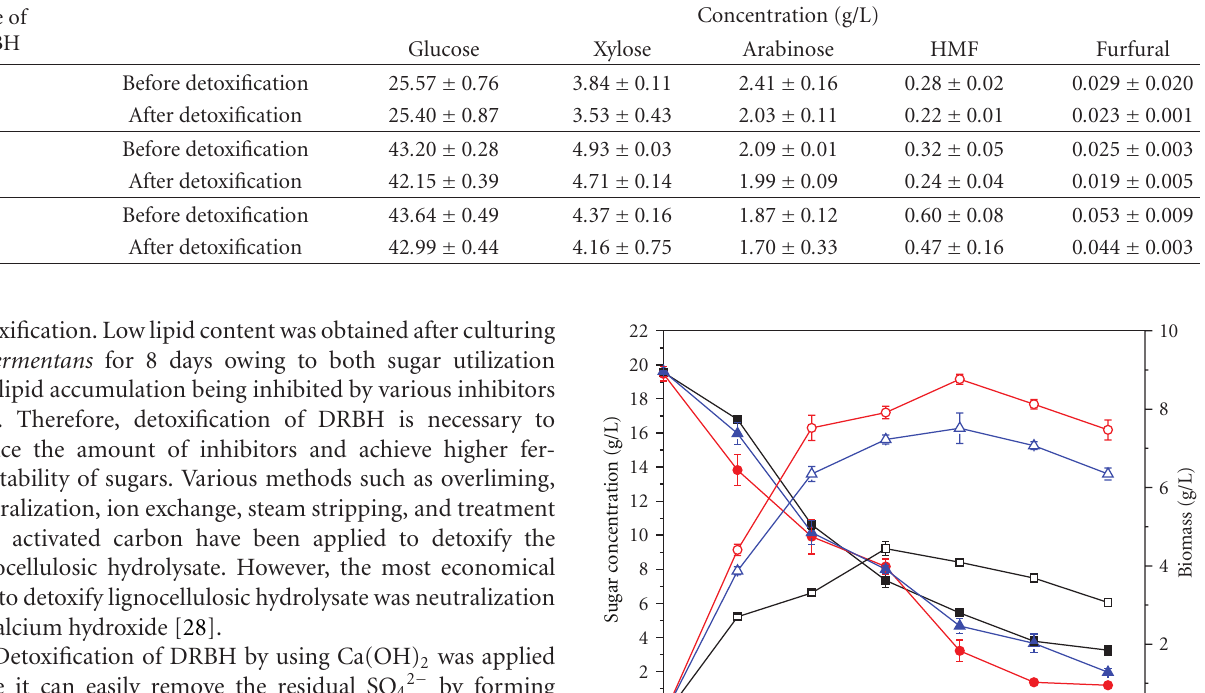
Three di ff erent types of detoxified DRBHs were obtained from rice bran hydrolysis with three di ff erent acid